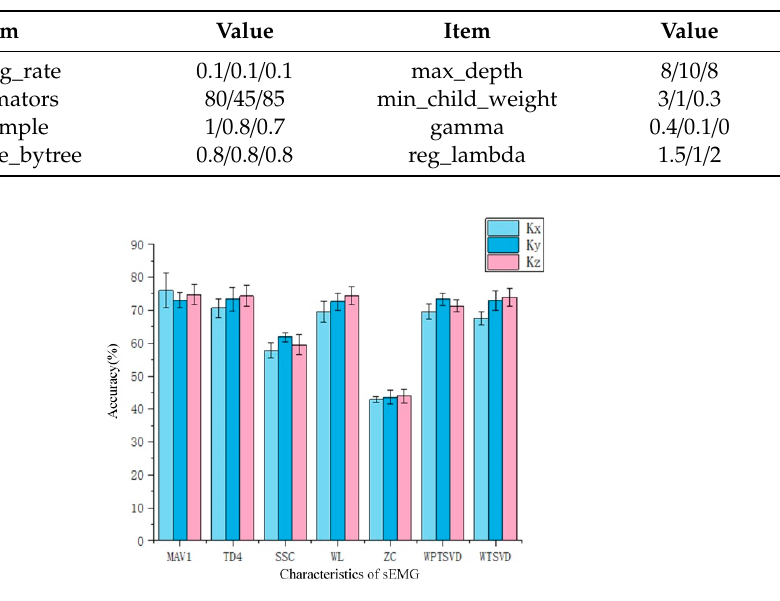
Figure 9. Accuracy of stiffness classification with XGBoost.